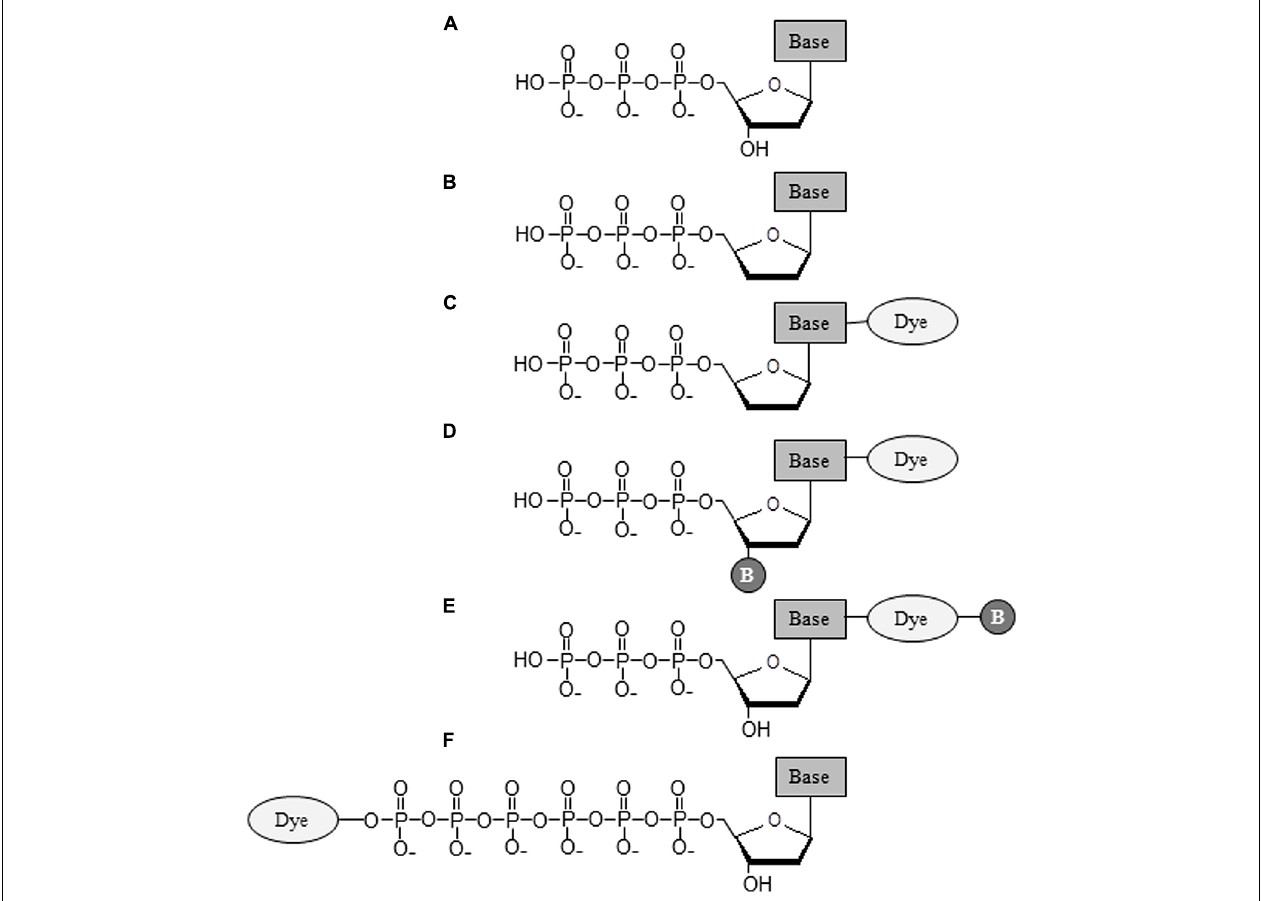
FIGURE 2 | Structures of nucleotides utilized in the generations of DNA polymerase-based sequencing methods. (A) Deoxynucleotides (dNTPs); (B) 2 (cid:2) , 3 (cid:2) -dideoxynucleotides (ddNTPs); (C) Dye-terminators; (D) Rever-